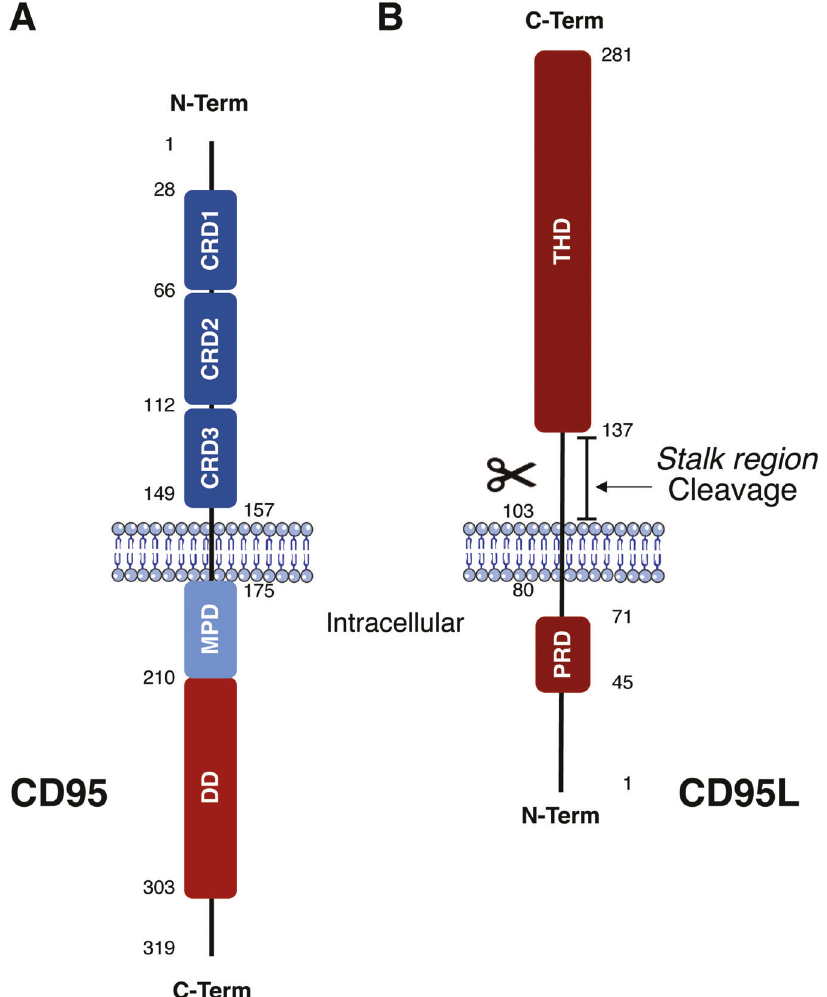
Fig. 1 The CD95 receptor and its cognate ligand CD95L. Schematic representation of the functional domains of the CD95 Death Receptor ( A ) and its ligand CD95L in its membrane-bound form ( B ). (DD Death Domain, MPD Membrane Proximal Domain, CRD Cysteine-Rich Domain, PRD Proline-Rich Domain, THD TNF Homology